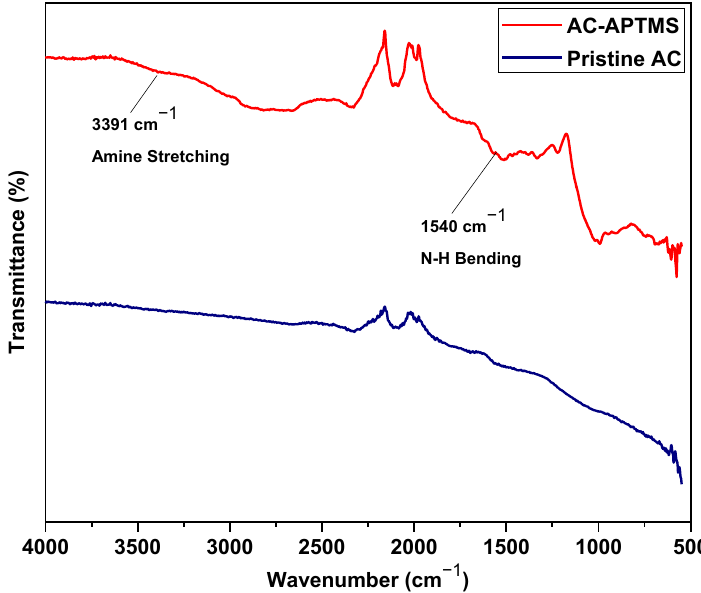
Figure 6. ATR-FTIR of pristine and APTMS functionalized AC.